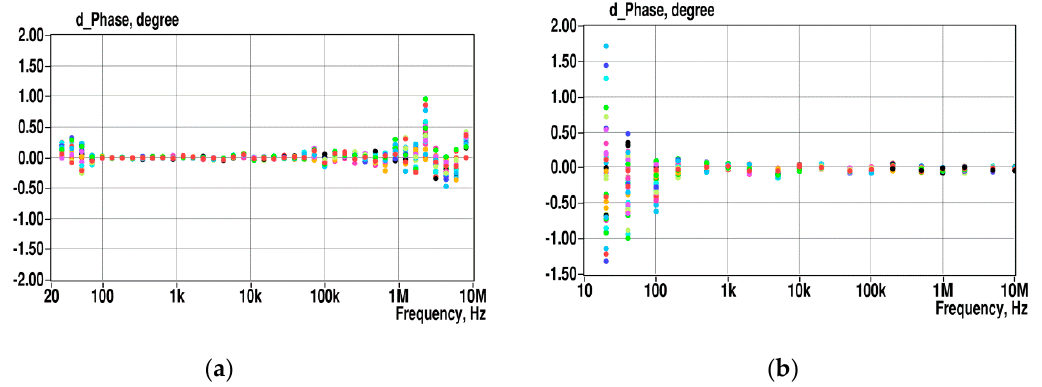
Figure A10. Impedance magnitude variations of the SUT1 measured with Wayne Kerr analyzer ( a ) and the developed analyzer ( b ).